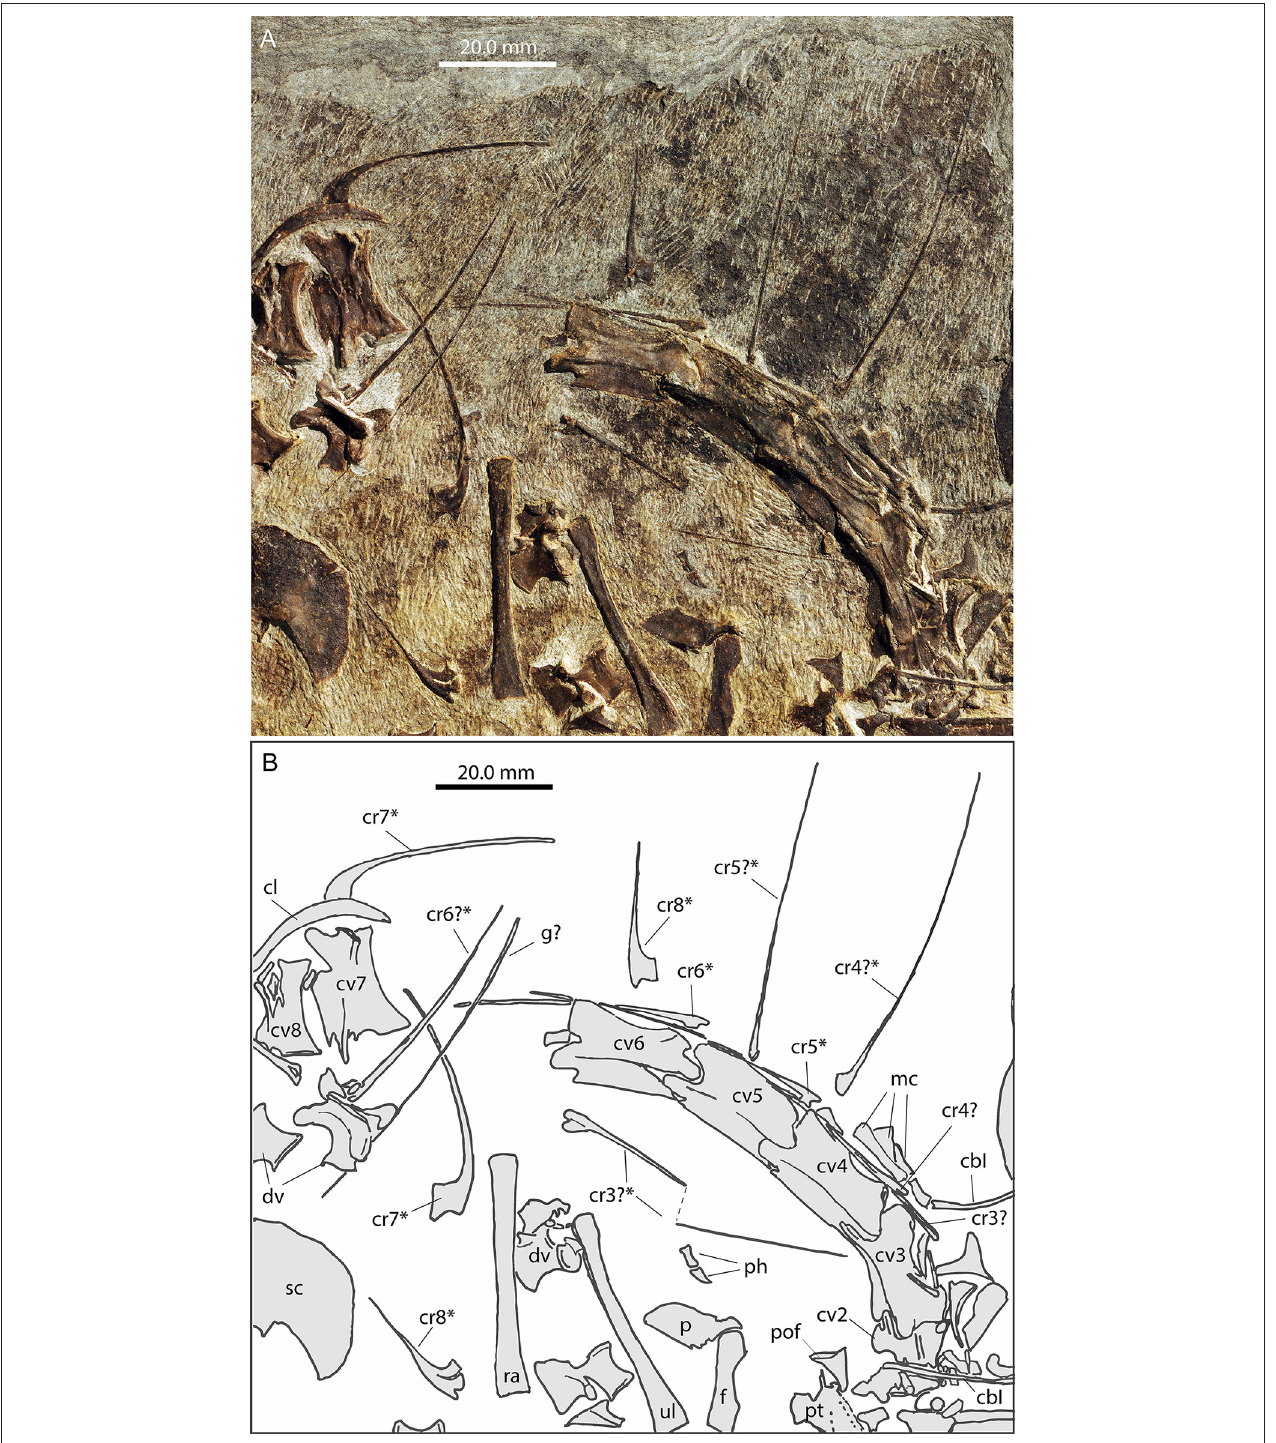
FIGURE 5 | Focus on the neck region of PIMUZ T 1559. (A) Photograph; (B) interpretative drawing. Cervical ribs that were measured ( Table 4 ) are marked with an asterisk (*). second sacral: Supplementary Figure 2). The base of the first sacral rib is robust and dorsoventrally expanded. In axial view, the rib first becomes more slender before expanding distally,